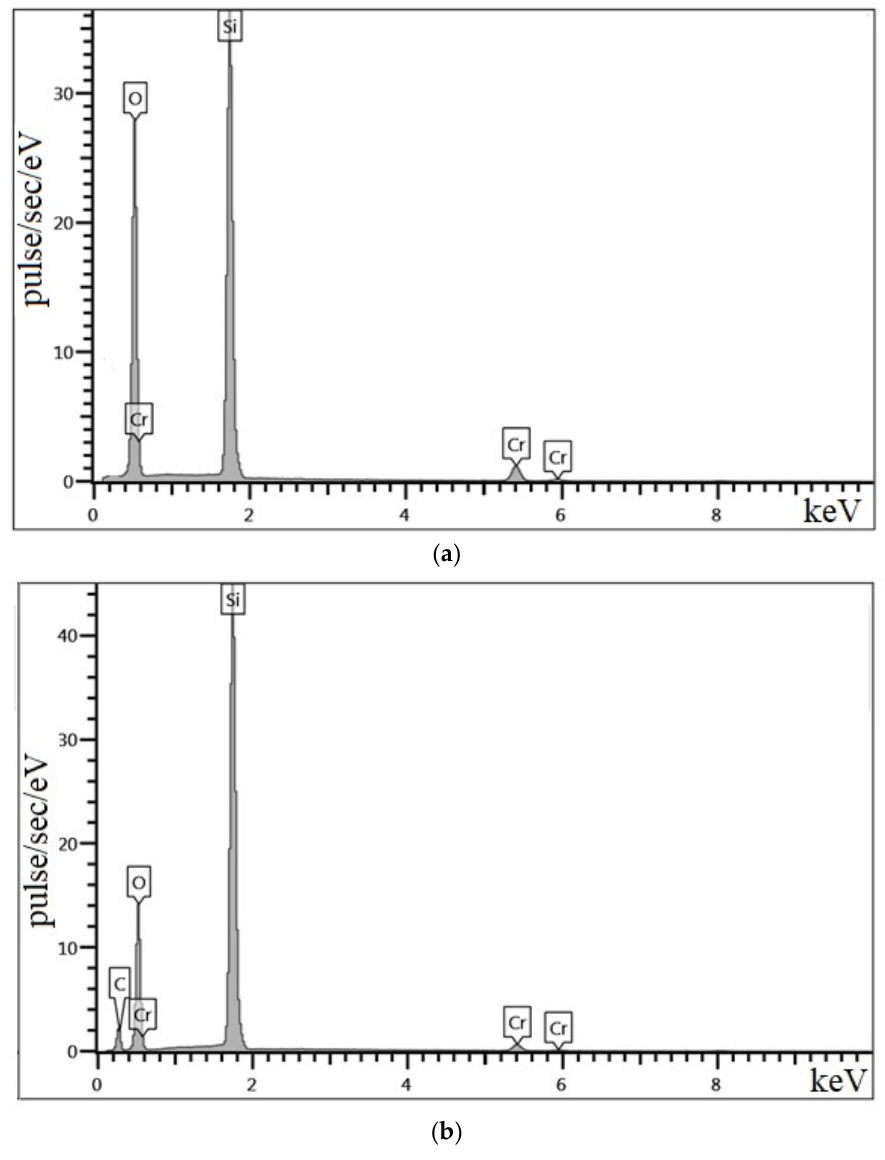
Figure 3. The EDX spectra of silica fi ller: ( a ) before microwave treatment and ( b ) after microwave Figure treatment.